Question: Give a one-sentence summary of this figure.
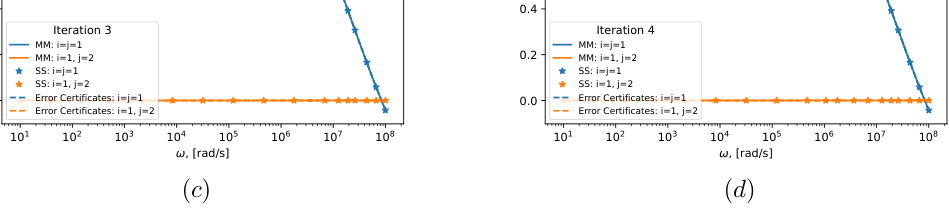
Answer: Magnetic conducting sphere: Showing p ˜ Rqij and p ˜ R ˘ ∆qij obtained by applying adaptive PODP in Algorithm 1 at iterations paq k “ 1, pbq k “ 2, pcq k “ 3, and pdq k “ 4.